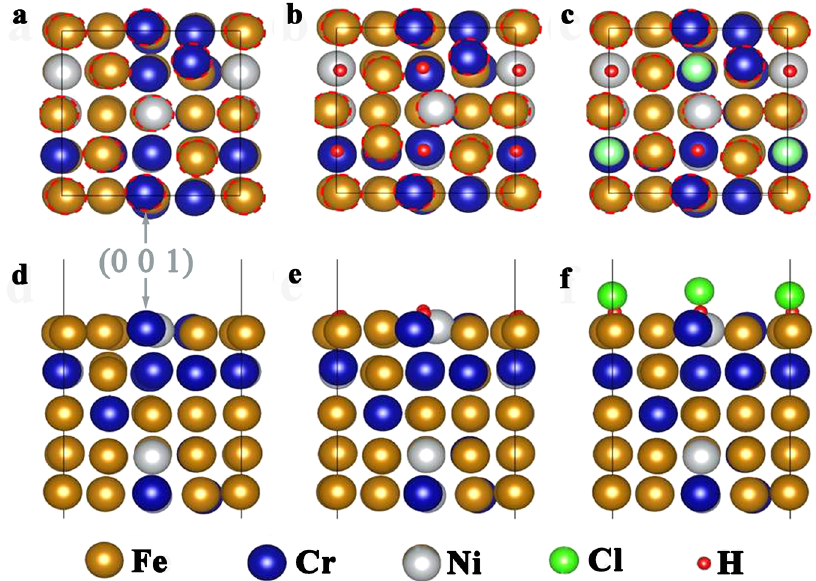
Fig. 2 H and Cl decreased surface energy of cleavage planes (0 0 1). a , d Optimized face-centered cubic slabs of Fe 5 Cr 2 Ni. b , e The slabs of Fe 5 Cr 2 Ni with 4 H atoms adsorbed in octahedral interstices. c , f The slabs of Fe 5 Cr 2 Ni with 2 H atoms and 2 Cl atoms adsorbed in octahedral interstices, where a – c and d – f show the top and corresponding side views, respectively. The atoms on the surface crystal planes (0 0 1) are marked by red dashed circles in ( a – c